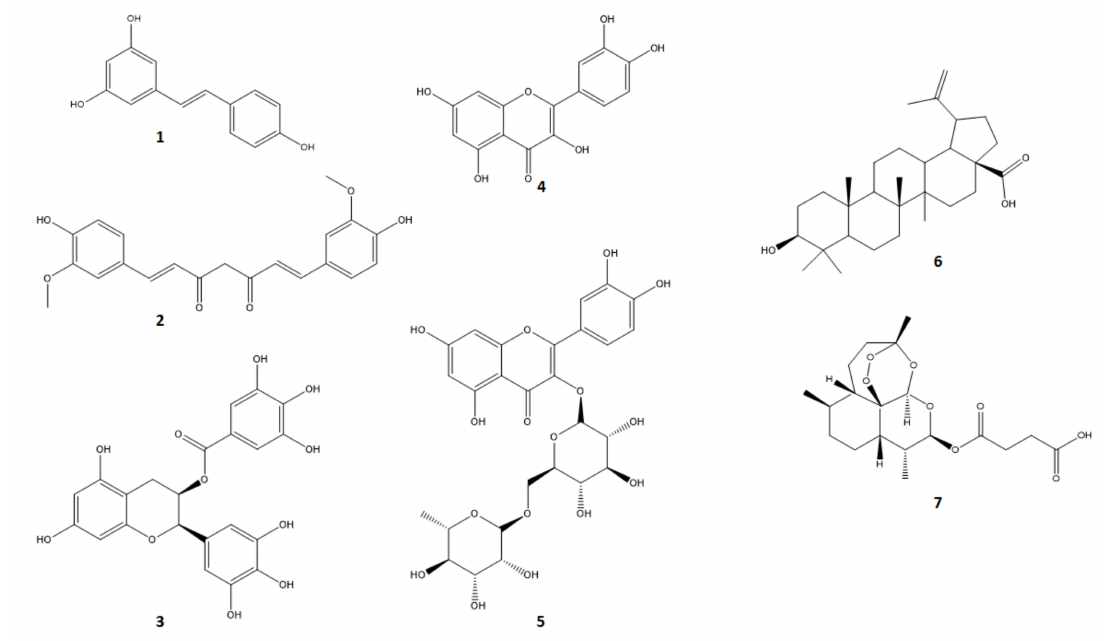
Figure 6. Chemical structures of (1) resveratrol, (2) curcumin, (3) EGCG, (4) quercetin, (5) rutin, (6) betulinic acid and (7)